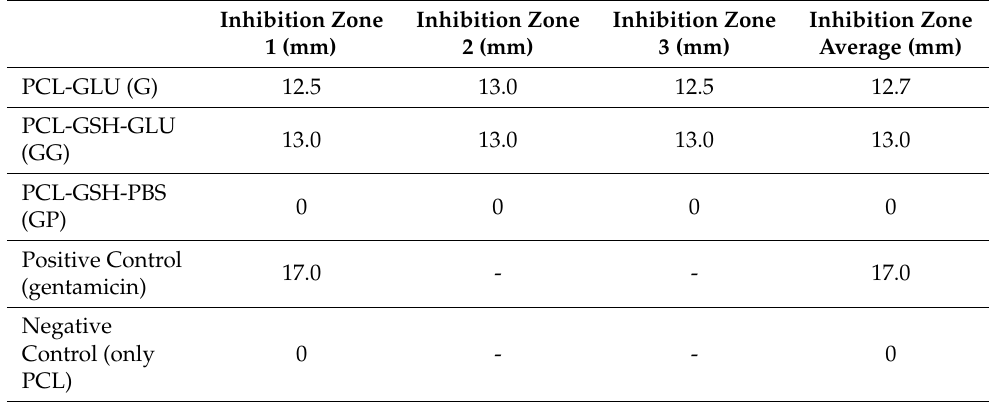
Figure 10. The result pictures of inhibition zone measurement for Kirby-Bauer Disk Diffusion/Inhibition Test. ( a ) PCL-GLU. ( b ) PCL-GSH-GLU. ( c ) PCL-GSH-PBS. ( d ) Positive control: Gentamicin. ( e ) Negative control: PCL. Table 2. The diameter of the clear zone from the Kirby-Bauer Disk Diffusion method (n = 3).